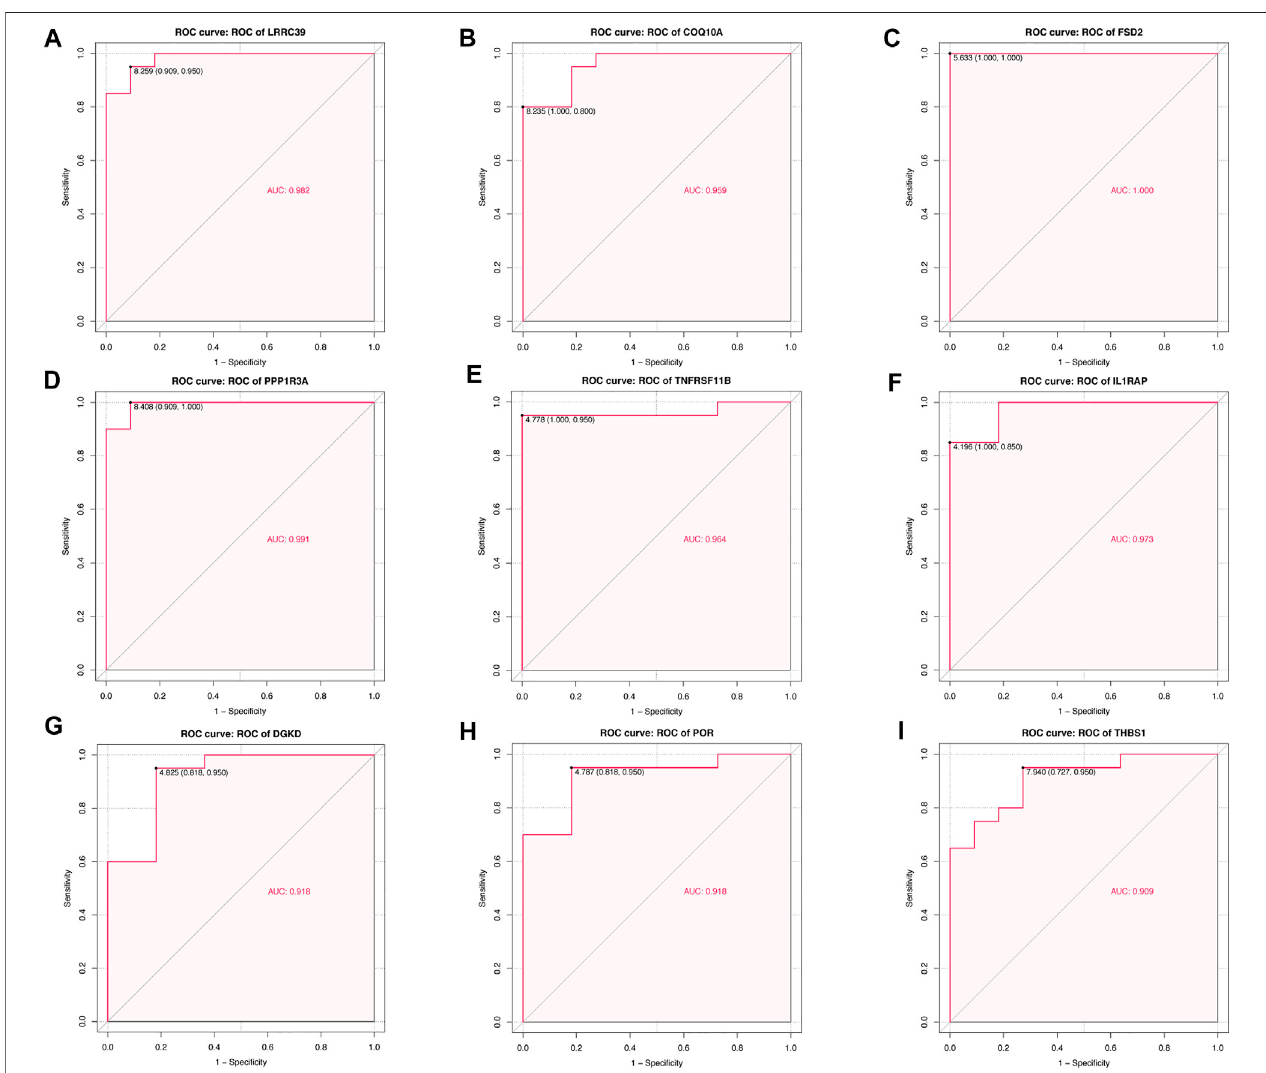
FIGURE 8 | Quanti fi cation of ROC curves. Values of AUC for (A) LRRC39 , (B) COQ10A , (C) FSD2 , (D) PPP1R3A , (E) TNFRSF11B , (F) IL1RAP , (G) DGKD , (H) POR , and (I) THBS1 .